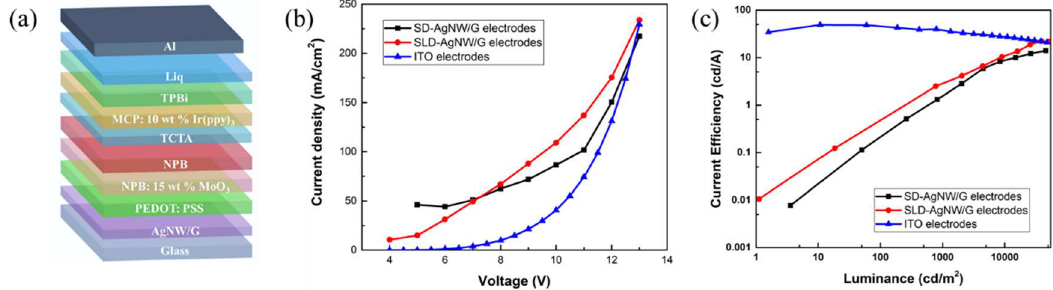
Figure 7. ( a ) The configuration of the organic light‐emitting diode (OLED) devices with silver nanowire/graphene electrodes. ( b ) Current density–voltage characteristics and ( c ) current efficiency‐luminance of OLED devices with indium tin oxide (ITO), SD‐AgNW/G, and SLD‐AgNW/G film as anodes.